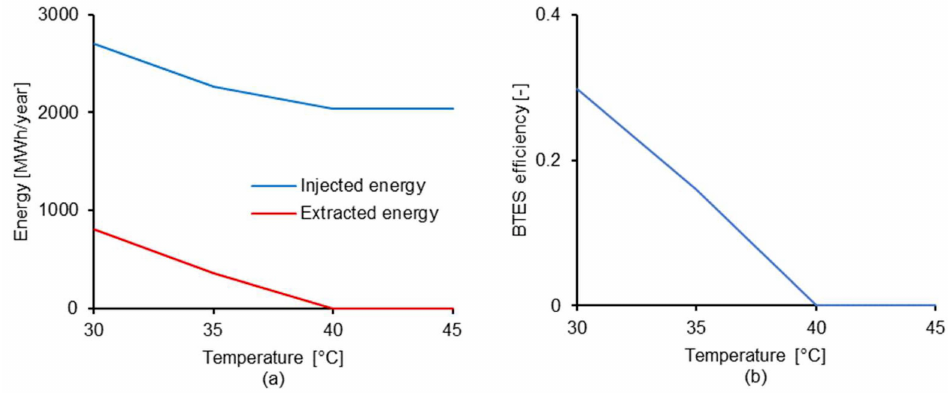
Figure 18. Annual injected and extracted energy ( a ) and BTES e ffi ciency ( b ) vs. minimum useful storage temperature for the actual storage supply flow at heat injection, Case